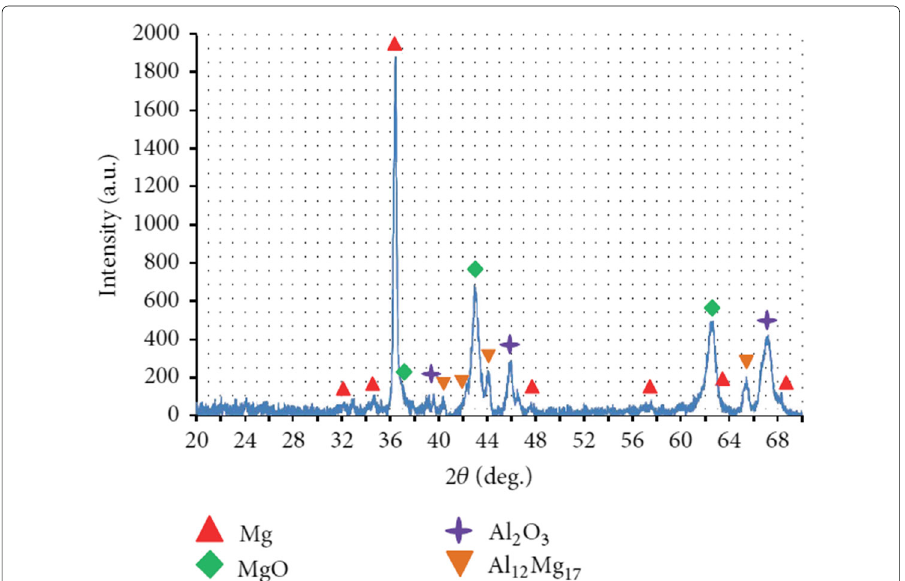
Fig. 3 XRD showing various phases formed after reaction betwen pure Mg and Al 2 O 3 [93]